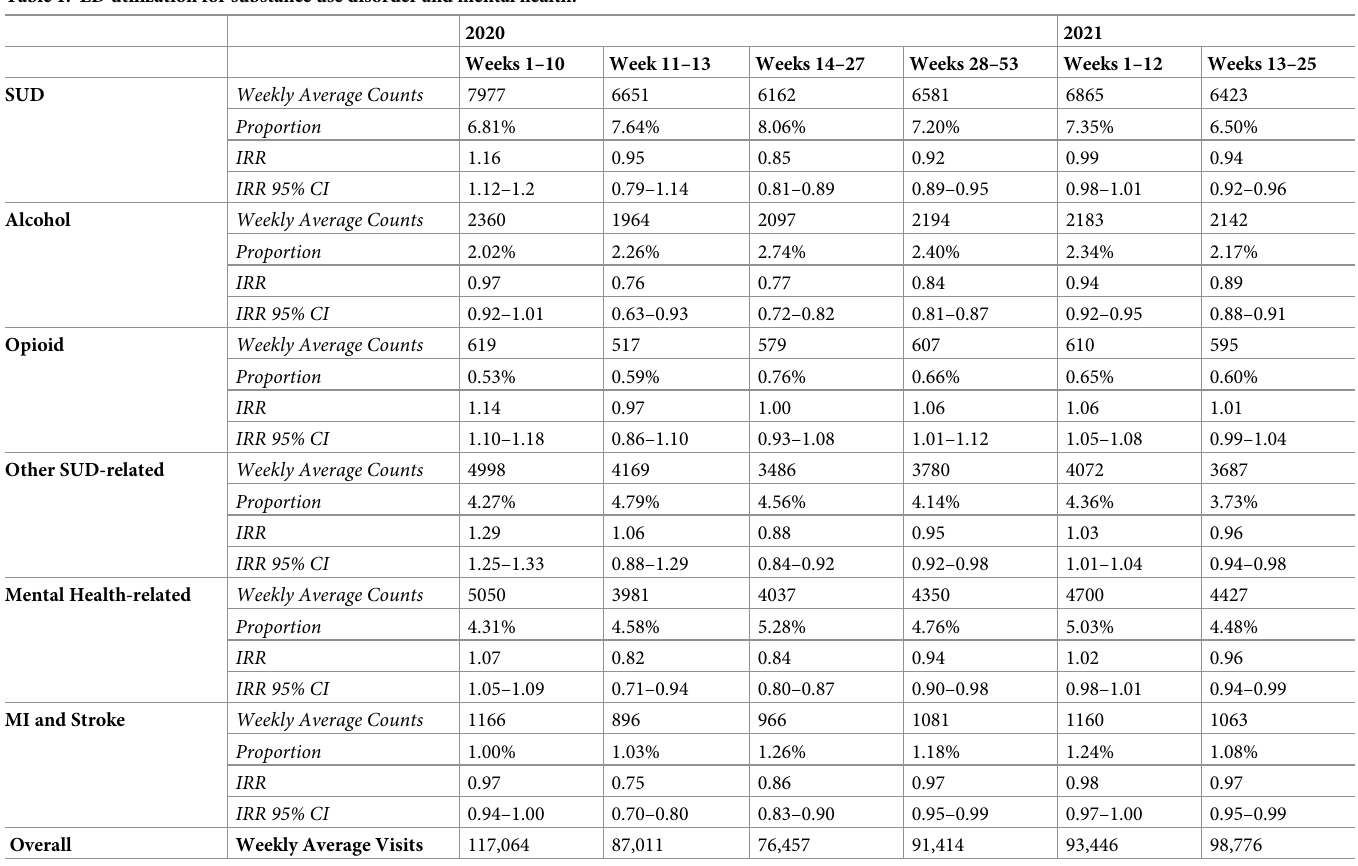
Table 1. ED utilization for substance use disorder and mental